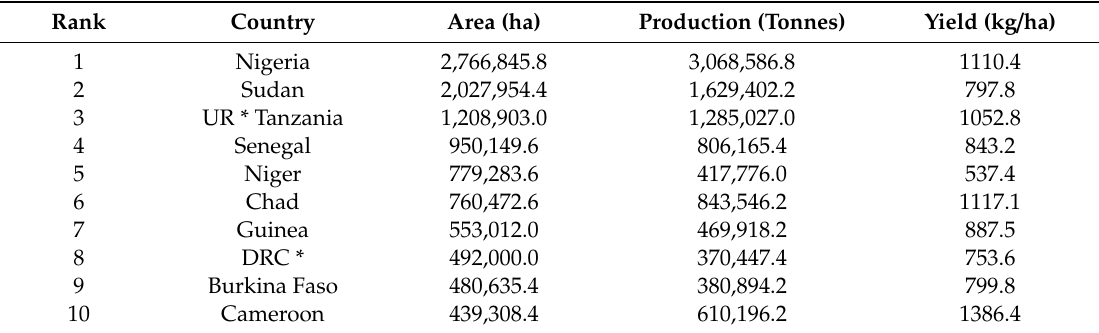
Figure 2. Map of groundnut production per administrative region in Burkina Faso, adapted based on the average of the last five years (2013–2017) [4]. 1: Boucle-du-Mouhoun; 2: Cascades; 3: Centre; 4: Centre-Est; 5: Centre-Nord; 6: Centre-Ouest; 7: Centre-Sud; 8: Est; 9: Hauts-Bassins; 10: Nord; 11: Plateau-Central; 12: Sahel; 13: Sud-Ouest. The choropleth map was drawn using R package GADMTools with breaks option “sd” (standard deviation). Table 2. Top 10 groundnut producing countries based on average area harvested in the last five years (2013–2017)